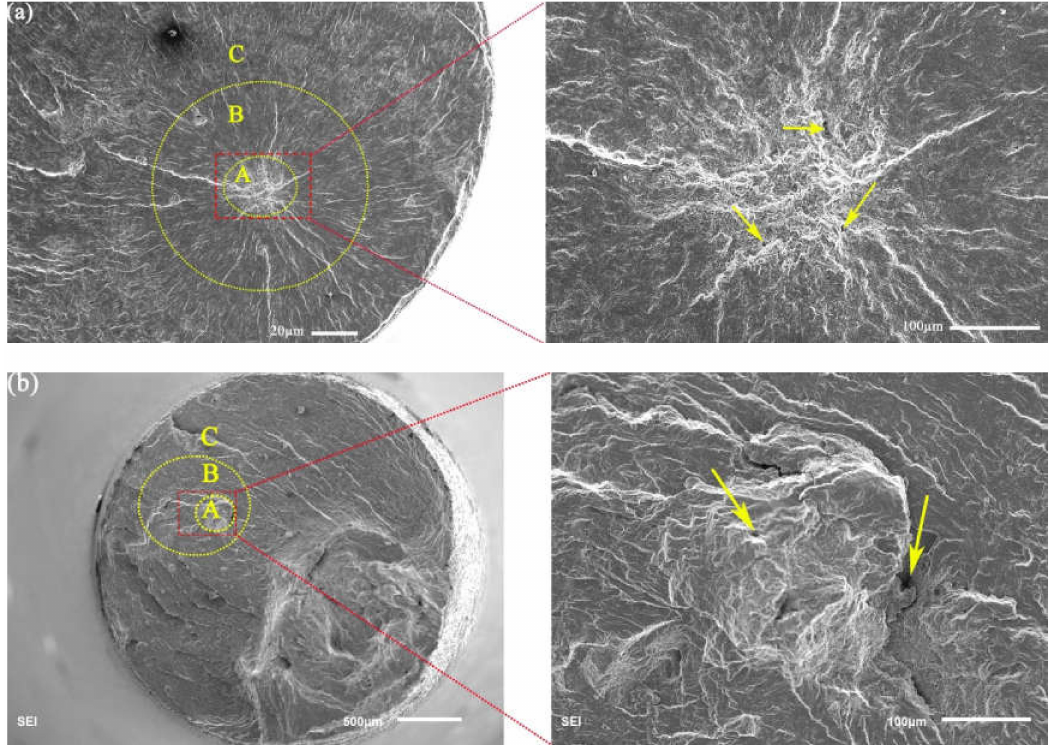
Figure 10. Typical fracture morphology of the failure specimen with internal cracks. ( a ) R = − 1, σ a = 130 MPa, N f = 1.93 × 10 8 cycles and ( b ) R = 0.1, σ a = 63 MPa, N f = 8.14 × 10 7